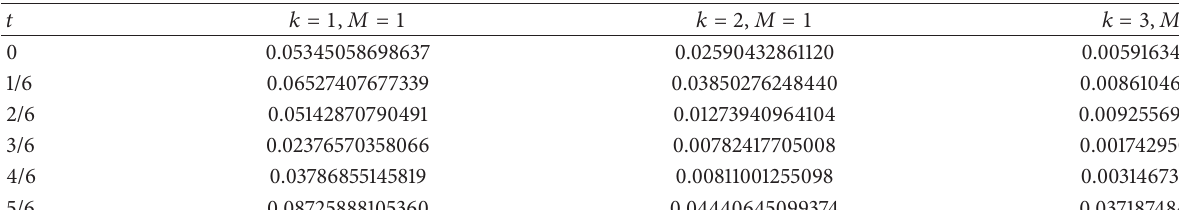
Table 1: Absolute errors for different values of 𝑘 , 𝑀 .